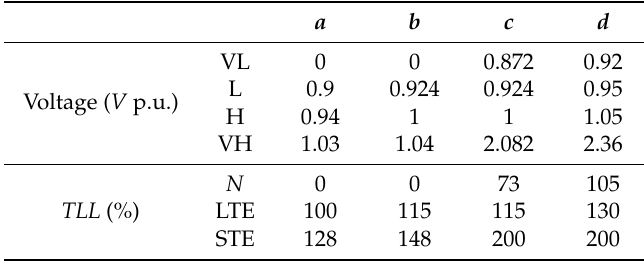
Table 2. Ranges of Membership